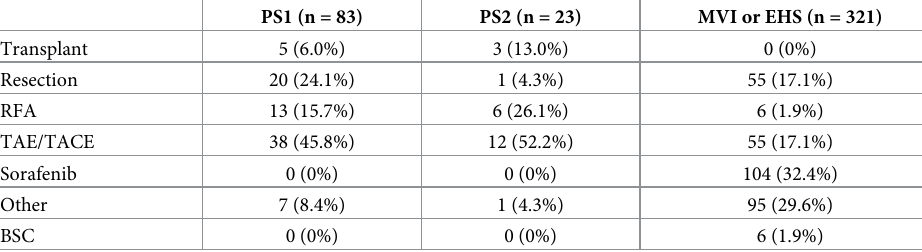
Table 2. Treatment distribution in the various BCLC C